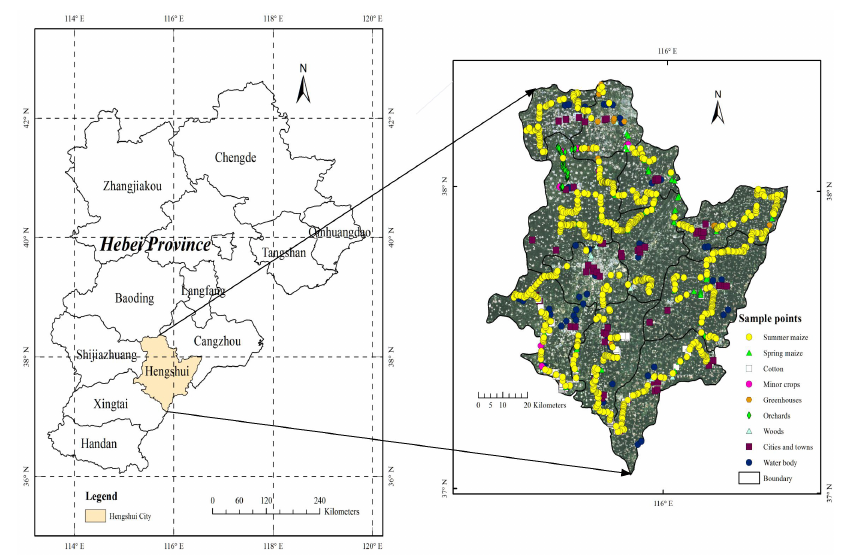
Figure 1. Geographical location and sample distribution of the study area. Table 2. Number of samples for different classes.